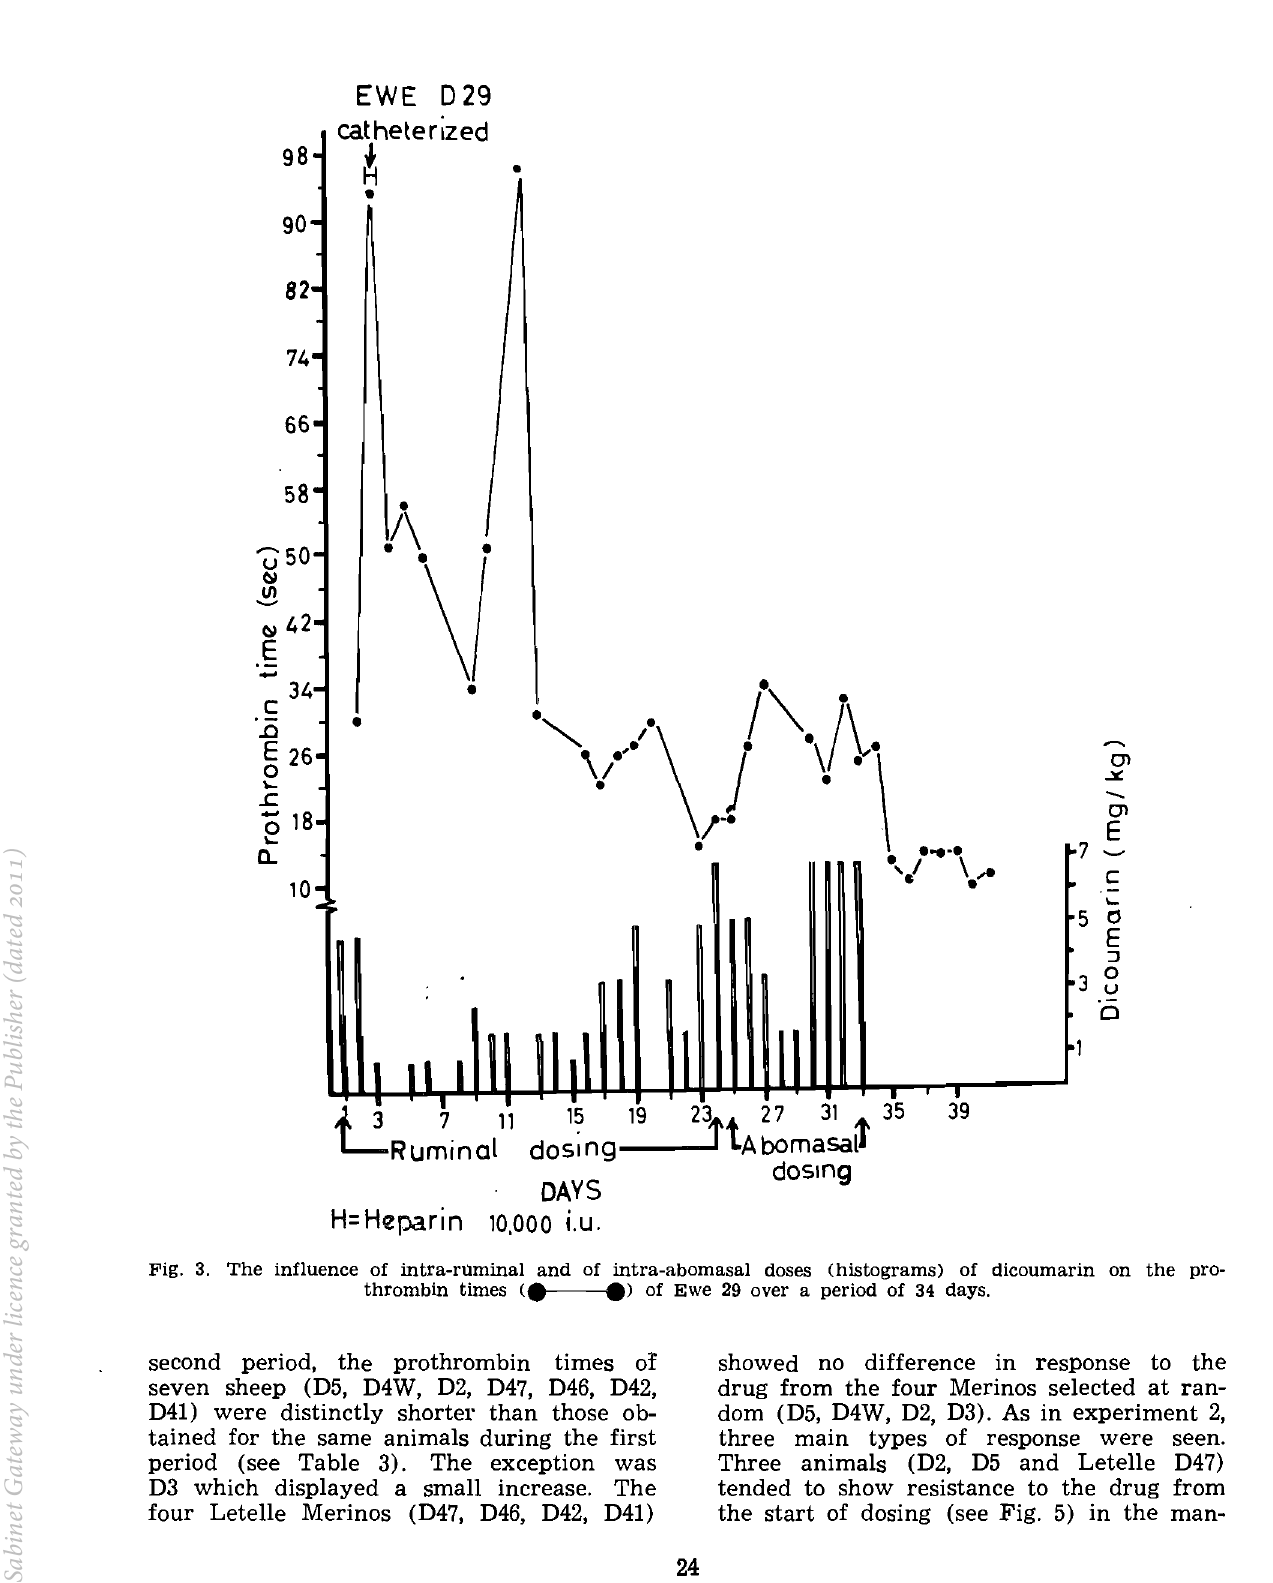
Fig. 3. The influence of intra-rumina! and of intra-abomasa! doses (histograms) of dicoumarin on the pro- thrombin times (. .) of Ewe 29 over a period of 34 days. second period, the prothrombin times of seven sheep (D5, D4W, D2, D47, D46, D42, D41) were distinctly shorter than those